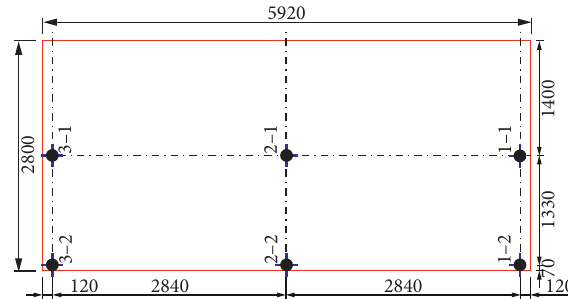
Figure 8: The arrangements of interlayer deformation measuring sensors (unit: mm).